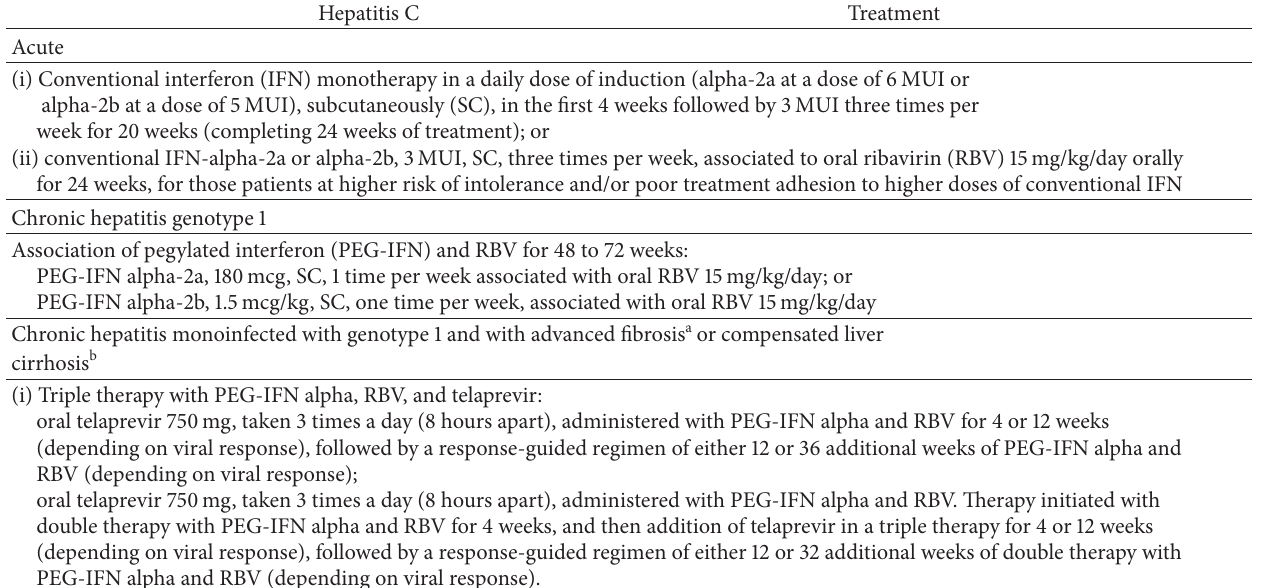
Table 3: Recommendations for the treatment of hepatitis C in Brazil according to the Ministry of Health [28, 29]. Hepatitis C